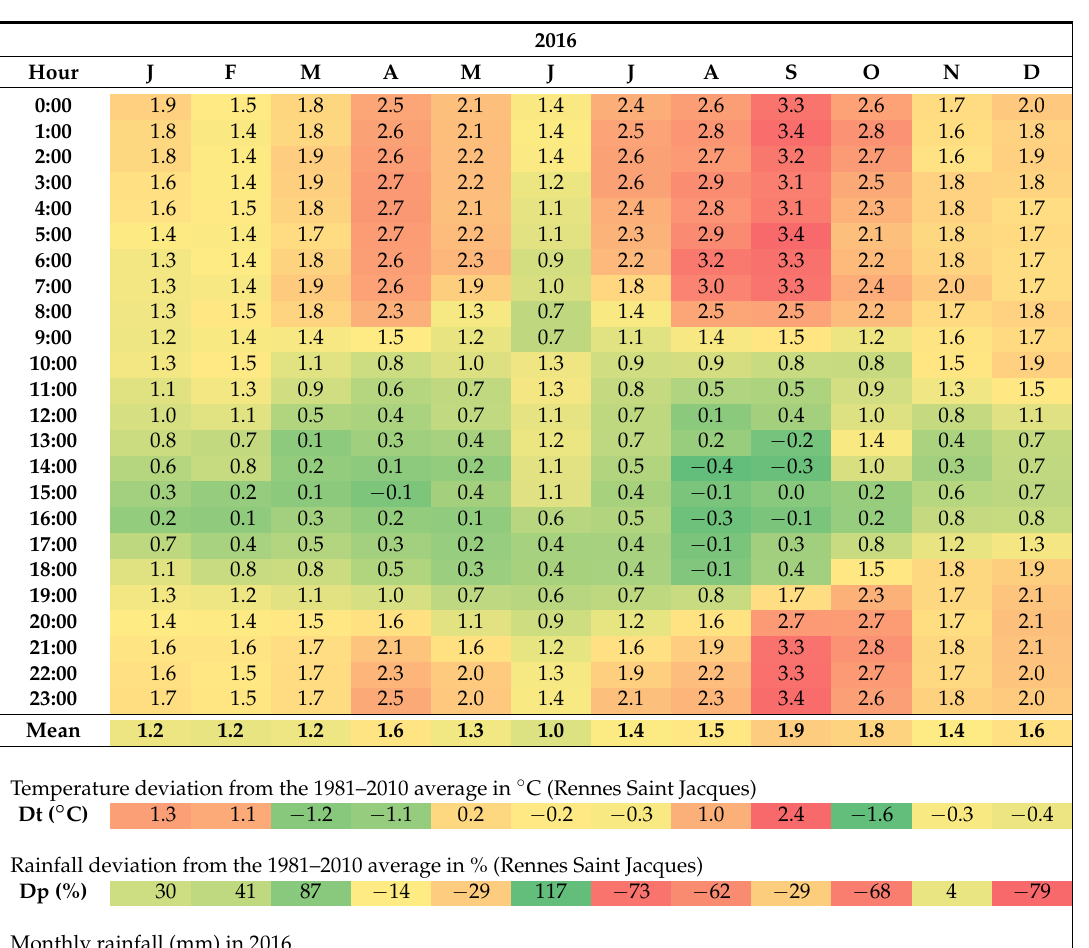
Table 2. Rennes, urban heat island: average hourly intensity, January to December 2016: temperature difference between the urban and rural